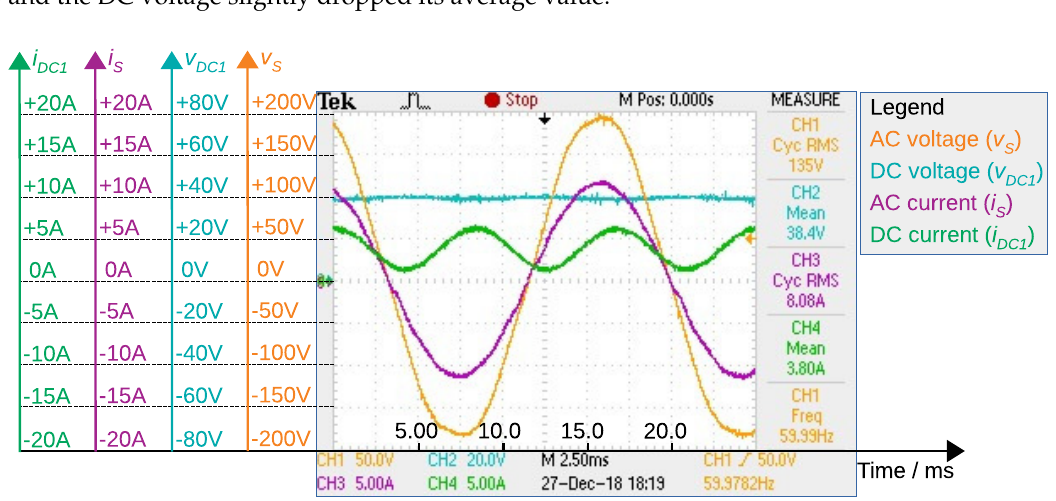
Figure 14. Measurements at 18:19 (of day 1)—Converter injecting active power (maximum) on the grid. At t = t 3 = 19 : 30 the converter starts to reduce active power injection into the grid, as a descending ramp, according to (6). At the end of the descending ramp (at t 4 = 21 : 00) the reference for the DC reaches zero. Figure 12 shows, during the interval t 3 = 19 : 30 ≤ t < t 4 = 21 : 00, the descending ramps on the AC power, DC power and DC. It can be noticed that, as the discharging current decreases past a given value, the DC voltage starts to slowly